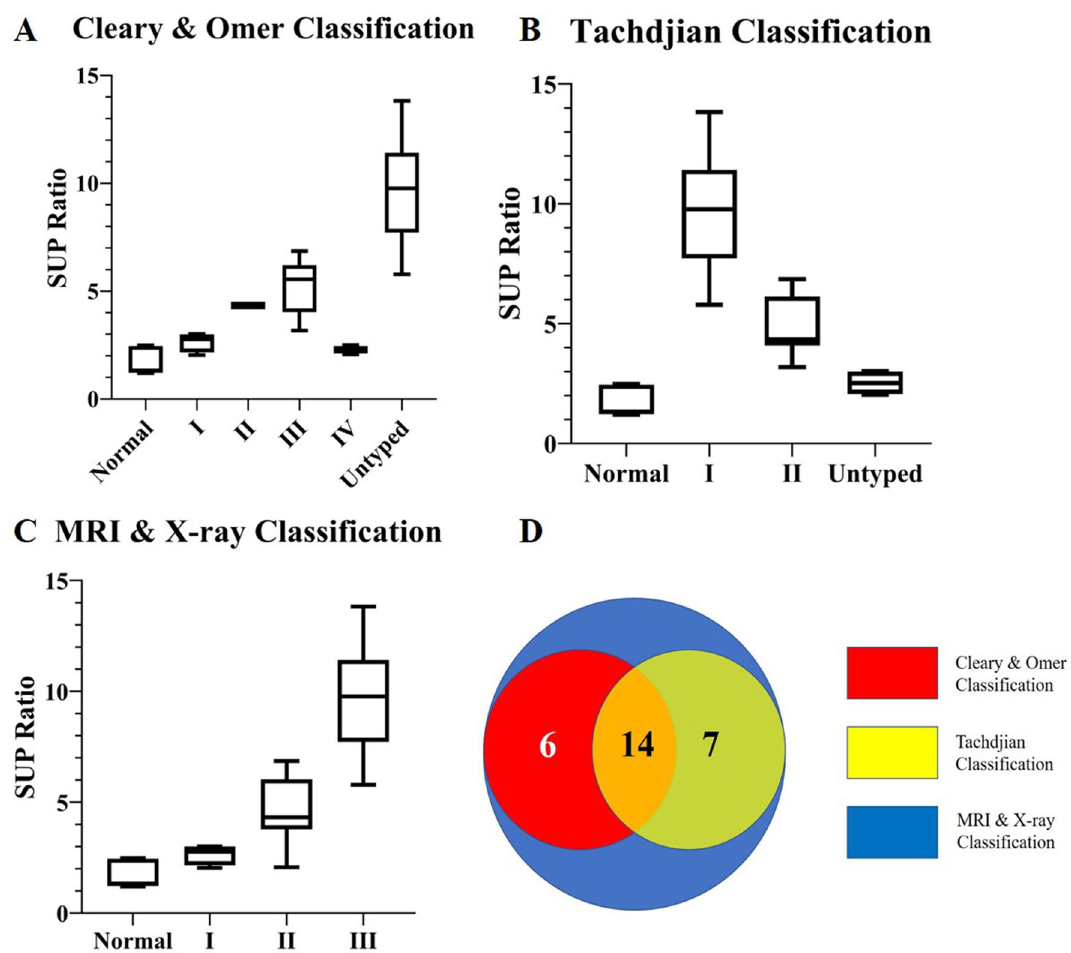
Figure 2. The distribution of SUP ratio of forearms included in this study in three classifications (Cleary & Omer ( A ), Tachdjian ( B ) and MRI & X-ray ( C )) and the relationship of coverage between the three classifications ( D ). Both Cleary & Omer classification and Tachdjian classification could neither cover all congenital PRUS forearms in this study nor make supinator ratio follow the ladder-shaped distribution. MRI & X-ray classification covered all forearms and provided ladder-shaped distribution of supinator ratio between type I, II,